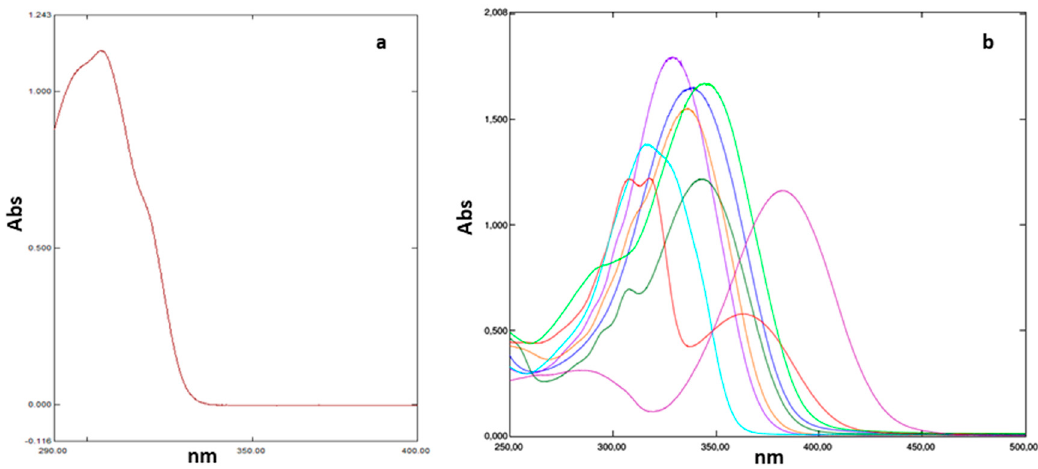
Figure 1. Panel a, UV spectra of the reference PBSA; panel b, UV absorption spectra of hydrazone derivatives: 4 (light blue), 5 (violet), 6 (dark green), 7 (red), 8 (blue), 9 (light green), 12 (orange), 13 (fuchsia).